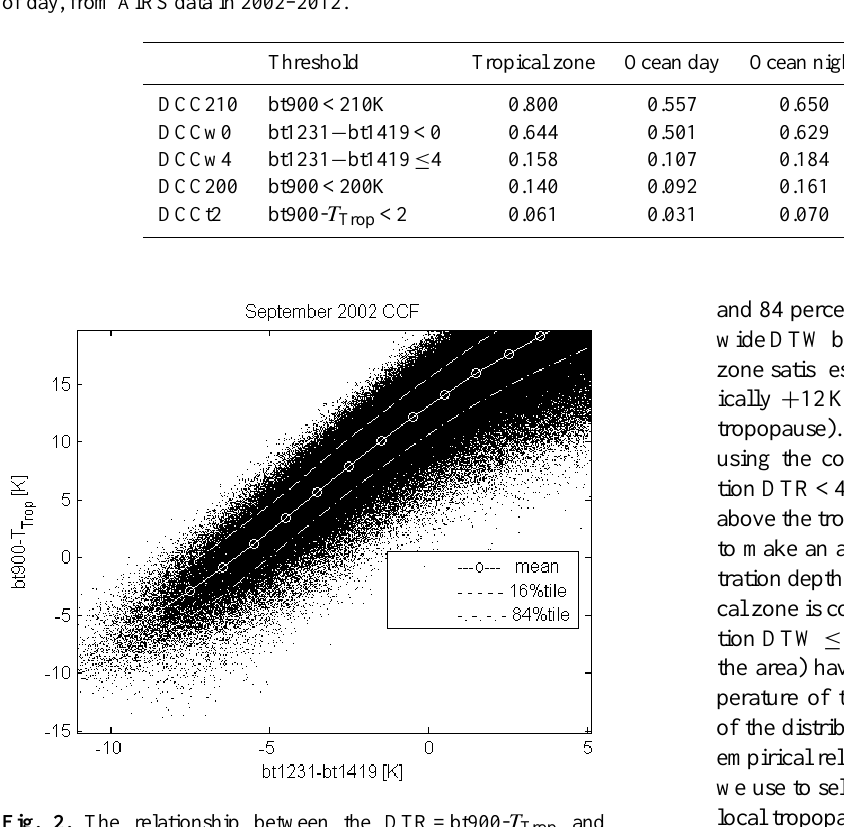
Table 1. Percent of DCCs identified with various IR brightness temperature thresholds and differences, segregated by surface type and time of day, from AIRS data in 2002–2012.